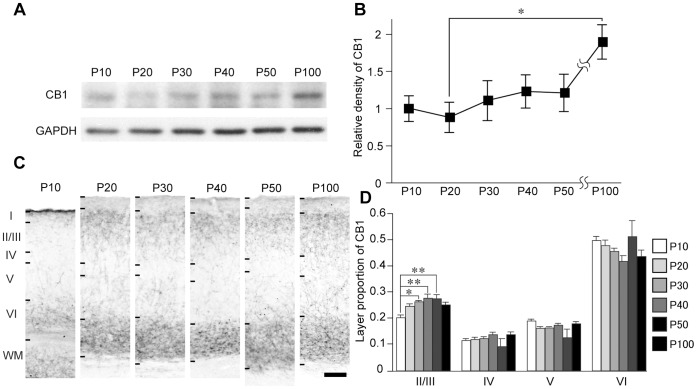
Developmental change of CB1 expression in V1.(A) Representative western blots of CB1 and GAPDH in V1 at different postnatal ages. (B) Mean and SEM of CB1 blot densities of each age group (n = 8 hemispheres each from 4 animals, one-way factorial ANOVA, p<0.05, post hoc Tukey’s test, *: p<0.05). The blot densities were normalized to the mean density of P10. (C) CB1 immunostaining of the binocular region of V1 at postnatal ages indicated on top. Scale, 100 µm. (D) Layer distribution of CB1 immunoreactivity in the binocular region of V1 at different postnatal ages. Mean and SEM of CB1 signal intensity in each layer represented as the proportion to the all-layer intensity (n = 4 animals, one-way factorial ANOVA, p<0.05; layer II/III, p>0.05; layers IV, V, and VI, post hoc Tukey’s test, *: p<0.05, **: p<0.01).